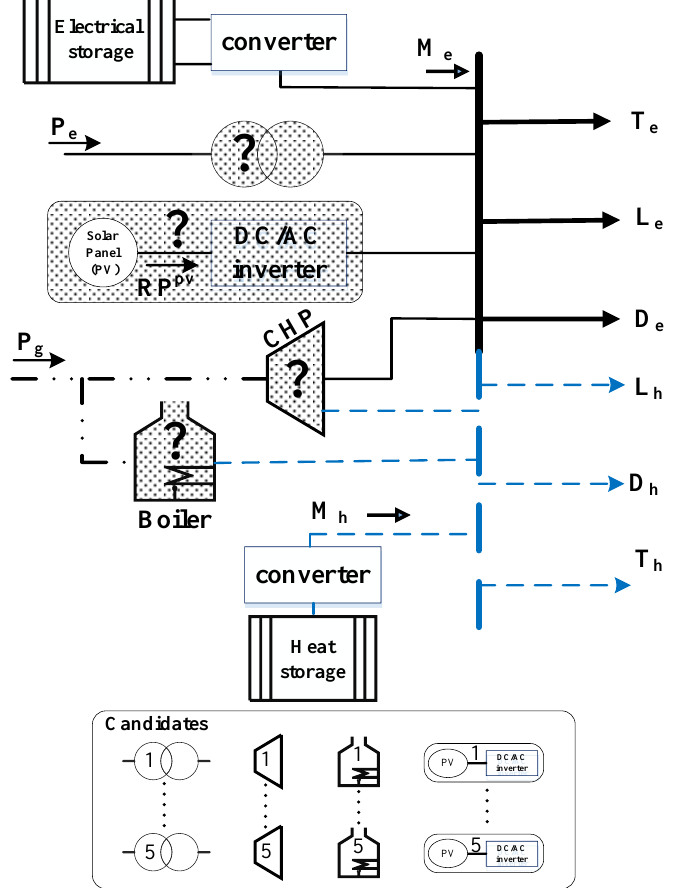
Figure 3. Desired MCMG for structural and operational optimizations.